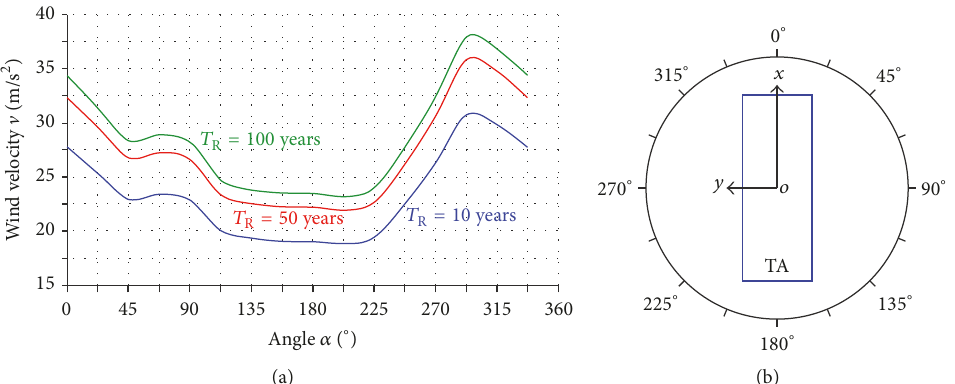
Figure 3: (a) Wind velocity as a function of the direction angle 𝛼 . (b) Angle 𝛼 relative to the position of the